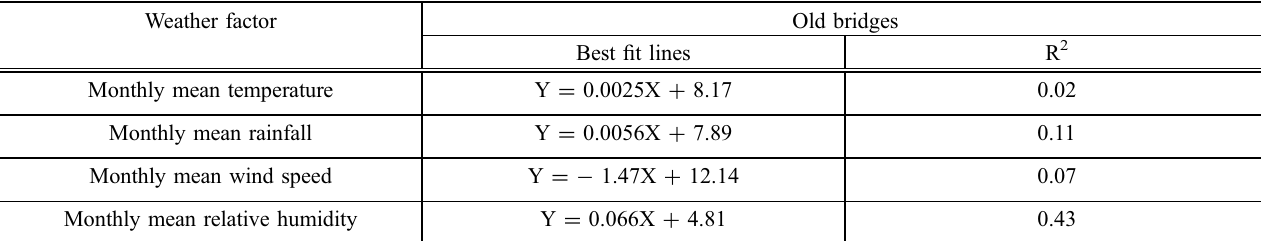
Table 2 Summary of equations for best fit lines and goodness of fit